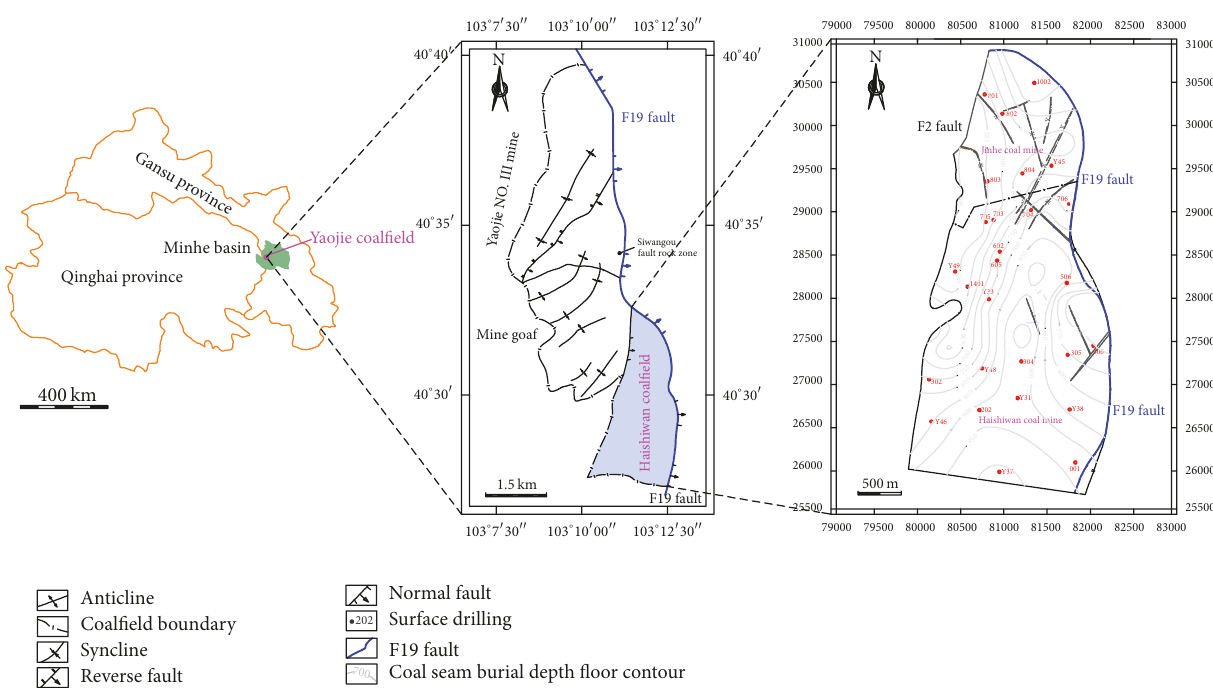
Figure 1: Geographical location of Yaojie coalfield and exploration of surface borehole in Haishiwan